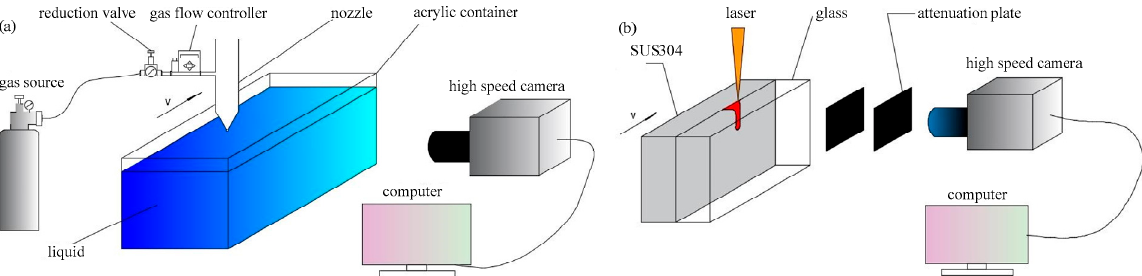
Figure 2. Diagram of the keyhole behavior observation experimental setup: ( a ) Keyhole observation in analogy welding; ( b ) Keyhole observation in real deep penetration laser welding with sandwich method.